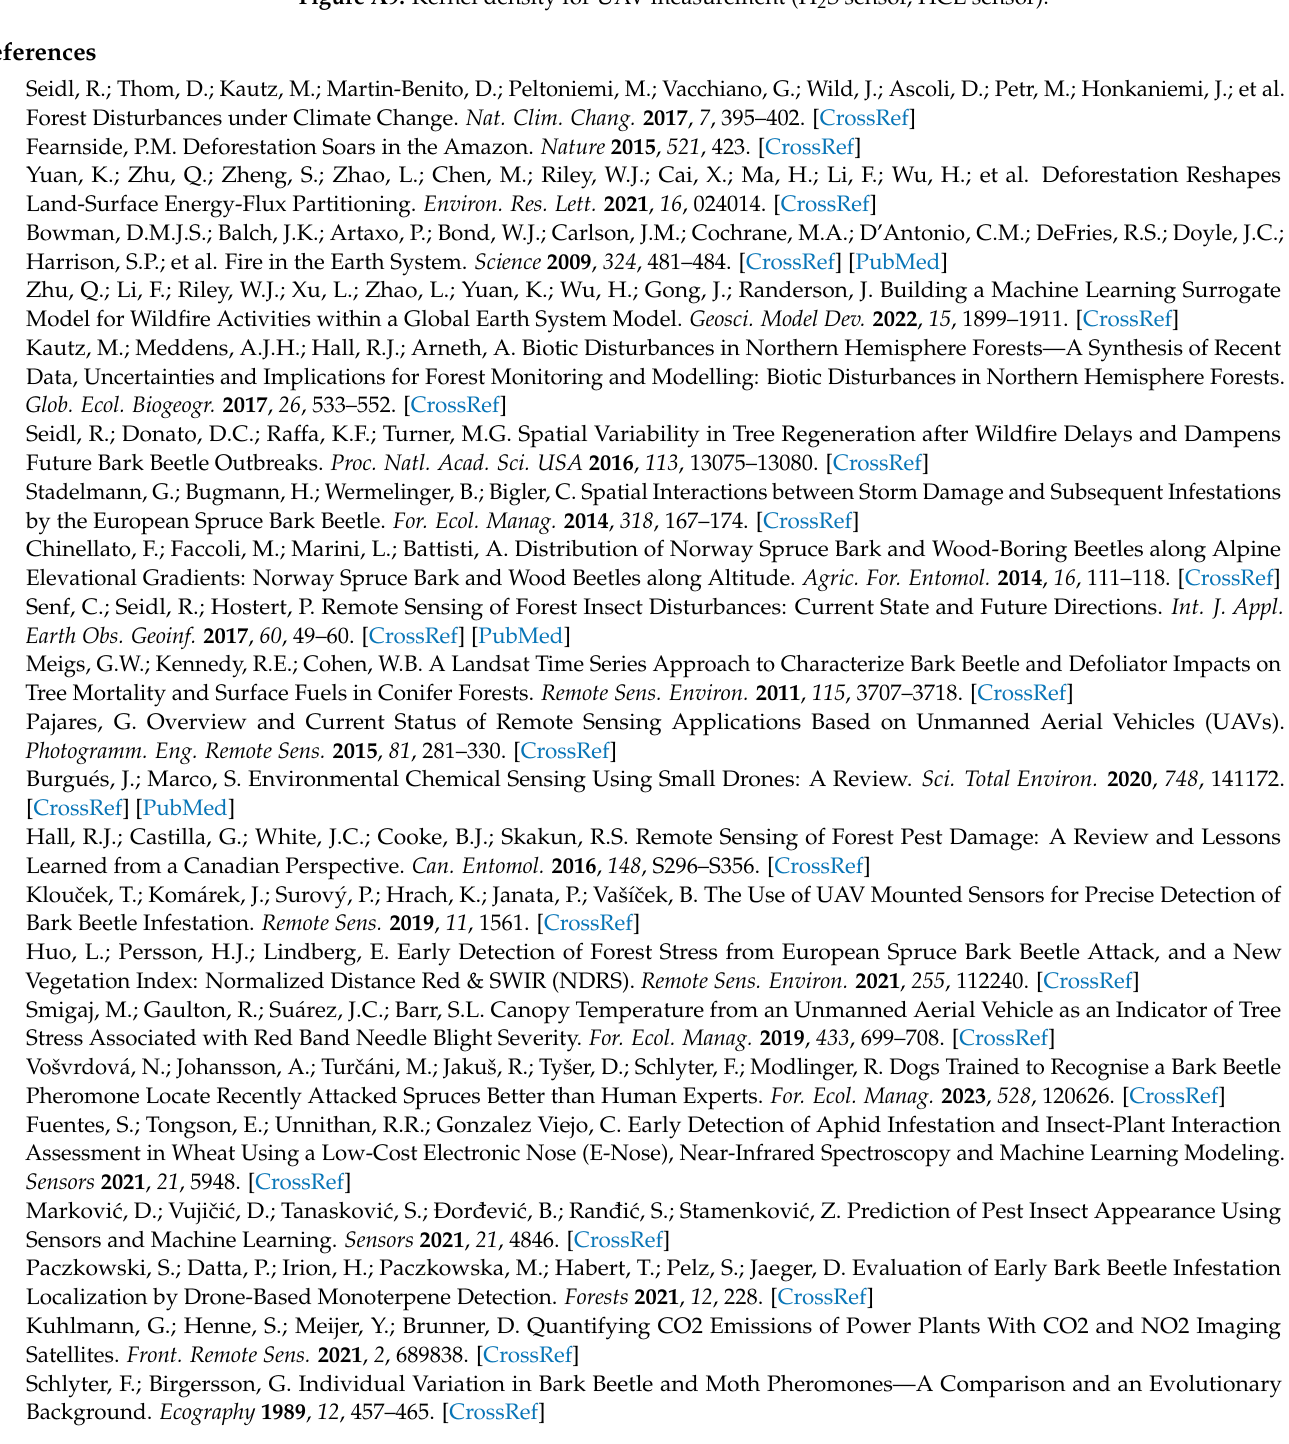
Figure A9. Kernel density for UAV measurement (H 2 S sensor, HCL sensor).